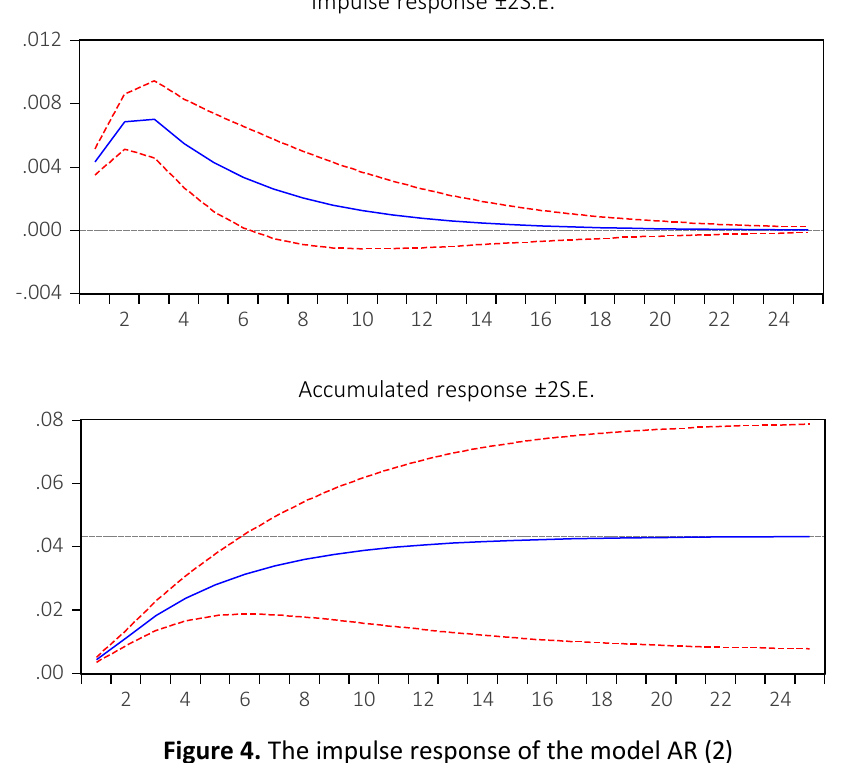
Figure 4. The impulse response of the model AR (2)